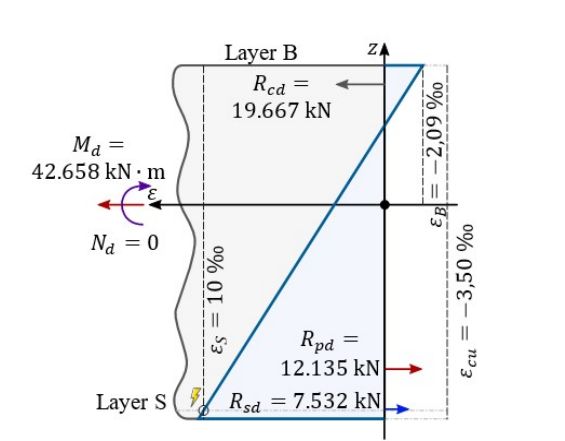
. 2 𝑑𝑑 𝑠𝑠 = 177,1 cm